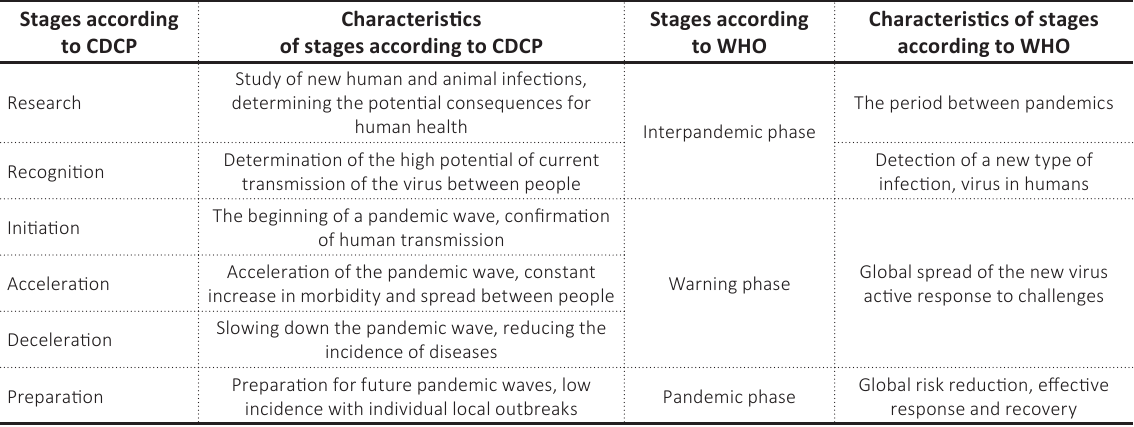
Table 2. Characteristics of the stages of the pandemic life